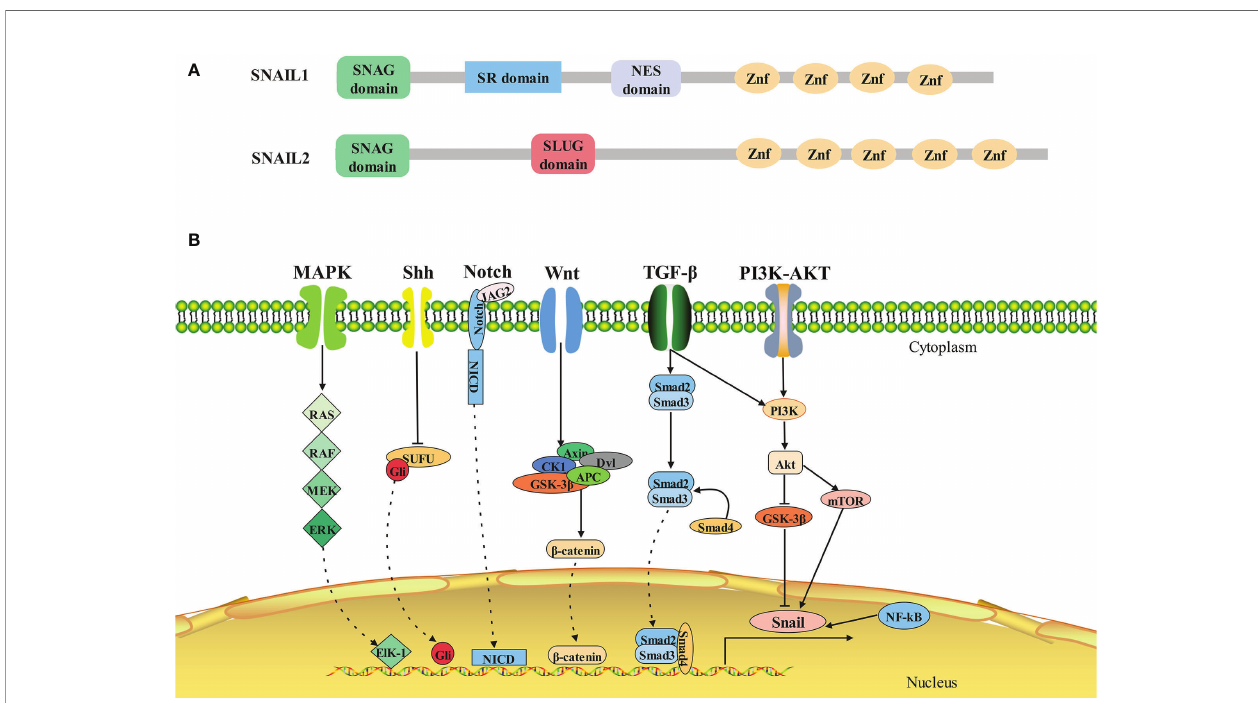
FIGURE 1 | Structure and signaling pathways of SNAIL1. (A) Architecture of SNAIL1 in human. Composite of the overall structure of Snail1 and Snail2, which shows the relative positions of the SNAG domain, the zinc fi ngers (I – V), and the Slug-speci fi c boxes, NES domain and serine-rich domain. (B) The molecular signaling pathways of SNAIL1. Snail1 is regulated by several signaling pathways that promote its expression. From left to right: MAPK, Shh, Notch, Wnt, TGF- b , PI3K-AKT, and NF- k B signaling